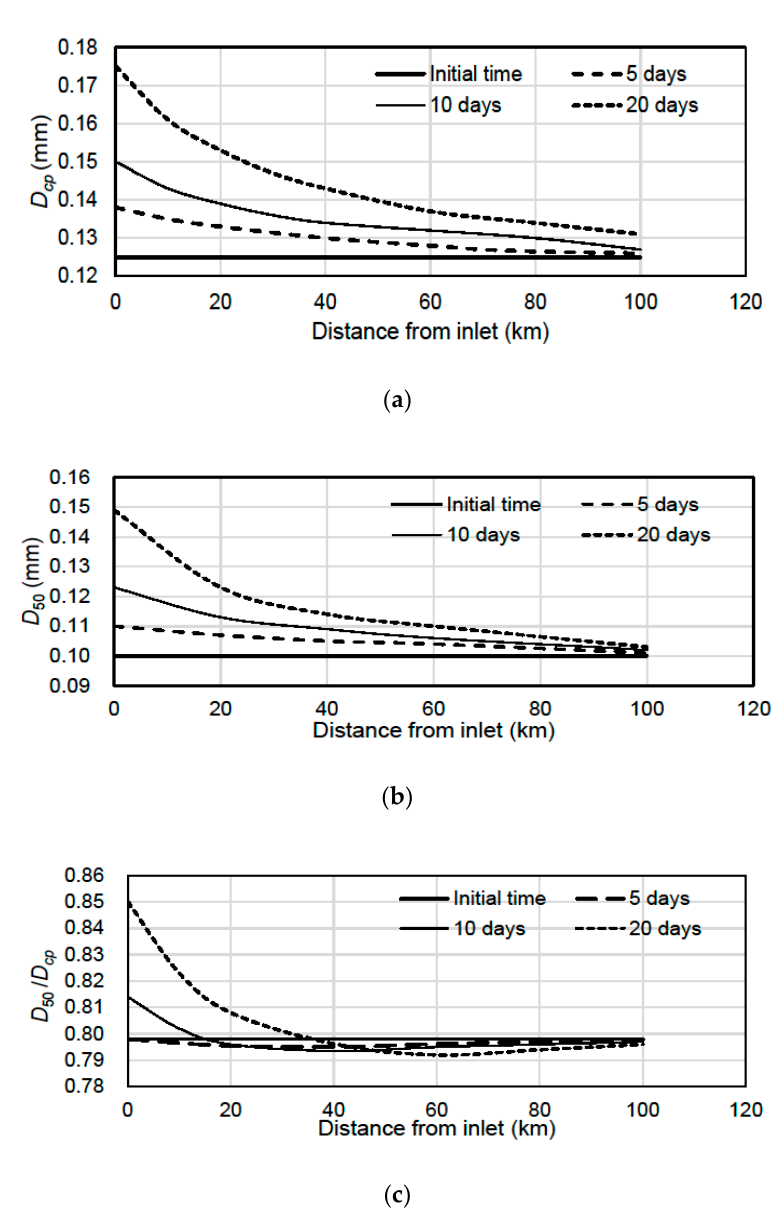
Figure 4. Temporal variation in the suspended-load under erosion conditions. ( a ) d cp ; ( b ) d 50 ; and ( c ) d 50 / d cp .